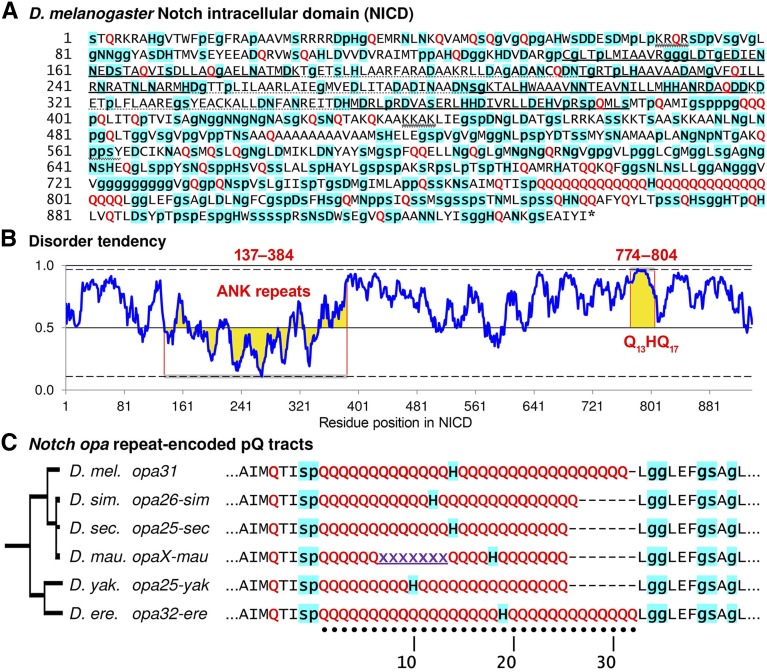
The cleaved Notch intracellular domain (NICD) is characterized by a polyglutamine (pQ) tract configuration that is unique to each Drosophila species. (A) Shown is the 939-residue-long polypeptide sequence for NICD from D. melanogaster. Residues that tend to be secondary structure breakers are highlighted in cyan (p, g, s, D, N, and H), with the smaller amino acids shown in lowercase lettering. Glutamines (Qs) are shown in red. The seven ankyrin repeats are shown in alternating bold and dotted underlining. Two nuclear localization sequences, NLS1 (KRQR) and NLS2 (KKAK), are indicated with double wavy underlining. The Nedd4 ubiquitination site (ppsY) is also indicated in light wavy underlining. (B) Much of the NICD is disordered, as demonstrated by this plot of long disorder tendency based on pairwise energy content (IUPred) (Dosztányi et al. 2005a,b). The ankyrin (ANK) repeats (residue positions 137–384) and the pQ tracts (Q13HQ17 at residue positions 774–804) are notable for having the least and most disorder tendencies, respectively (highlighted in yellow). (C) The opa-encoded pQ repeats of the melanogaster subgroup are characterized by two adjacent pQ tracts separated by a single conserved histidine. While the surrounding amino acids are conserved, each species features a unique pQ configuration characterized by the length of the pQ tracts on either side of the histidine. The assembly for Drosophila mauritiana indicates a unique position for the His residue even though the entire opa repeat sequence is still uncertain (Garrigan et al. 2012). In this study, we refer to different Notch opa configurations by appending the length suffix to the word “opa.” We add an additional index when more than one configuration exists for a given length as distinguished by the position of the single histidine (e.g., opa25-sec
vs.
opa25-yak, or opa33a
vs.
opa33b in D. melanogaster). Unless a species is indicated (e.g., opa26-sim), all opa designations refer to alleles from D. melanogaster.